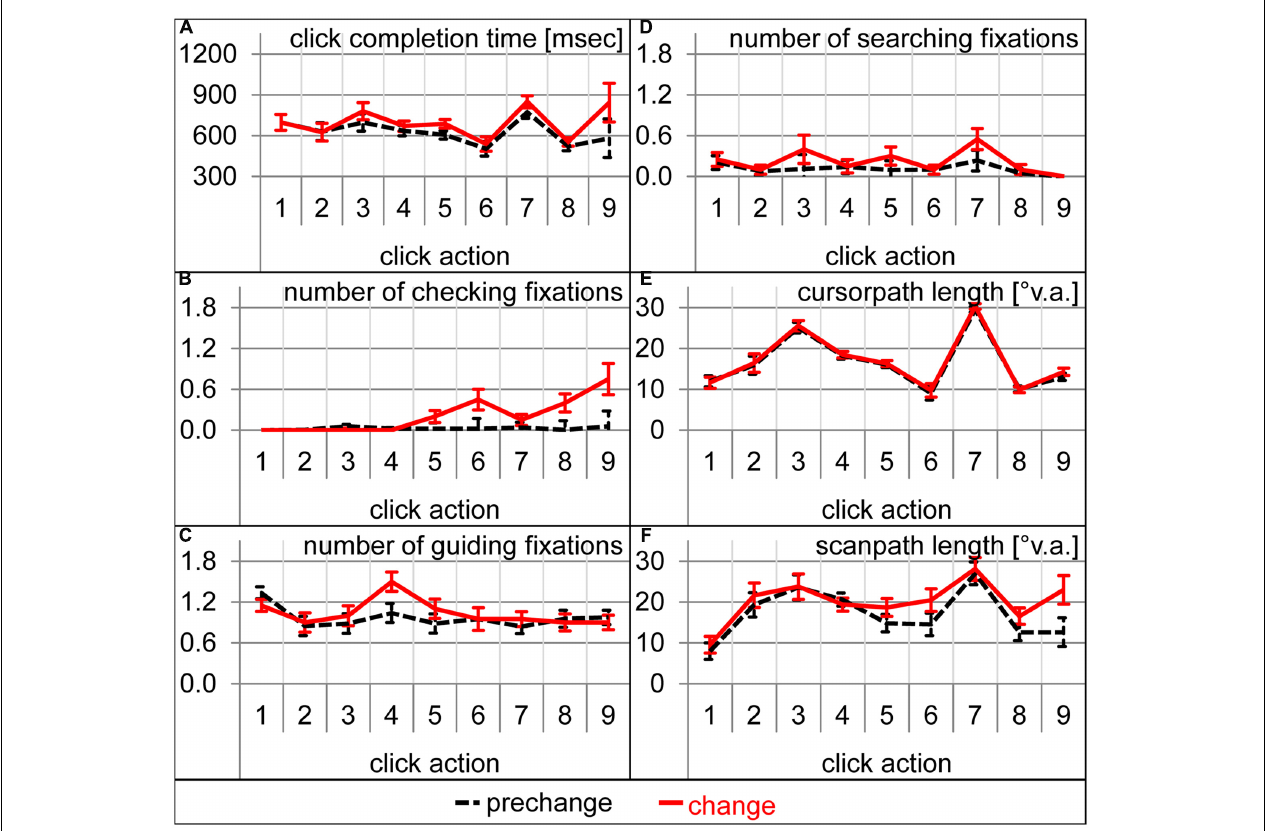
FIGURE 5 | Dependent variables during each of the nine clicking actions during prechange baseline (broken black lines) and the first change trial (solid red lines). Error bars represent standard errors of the paired difference between prechange and change for each click action. (A) Click completion time in milliseconds. (B) Number of checking fixations. (C) Number of guiding fixations. (D) Number of searching fixations. (E) Cursor-path length in ◦ v.a. (F) Scanpath length in ◦